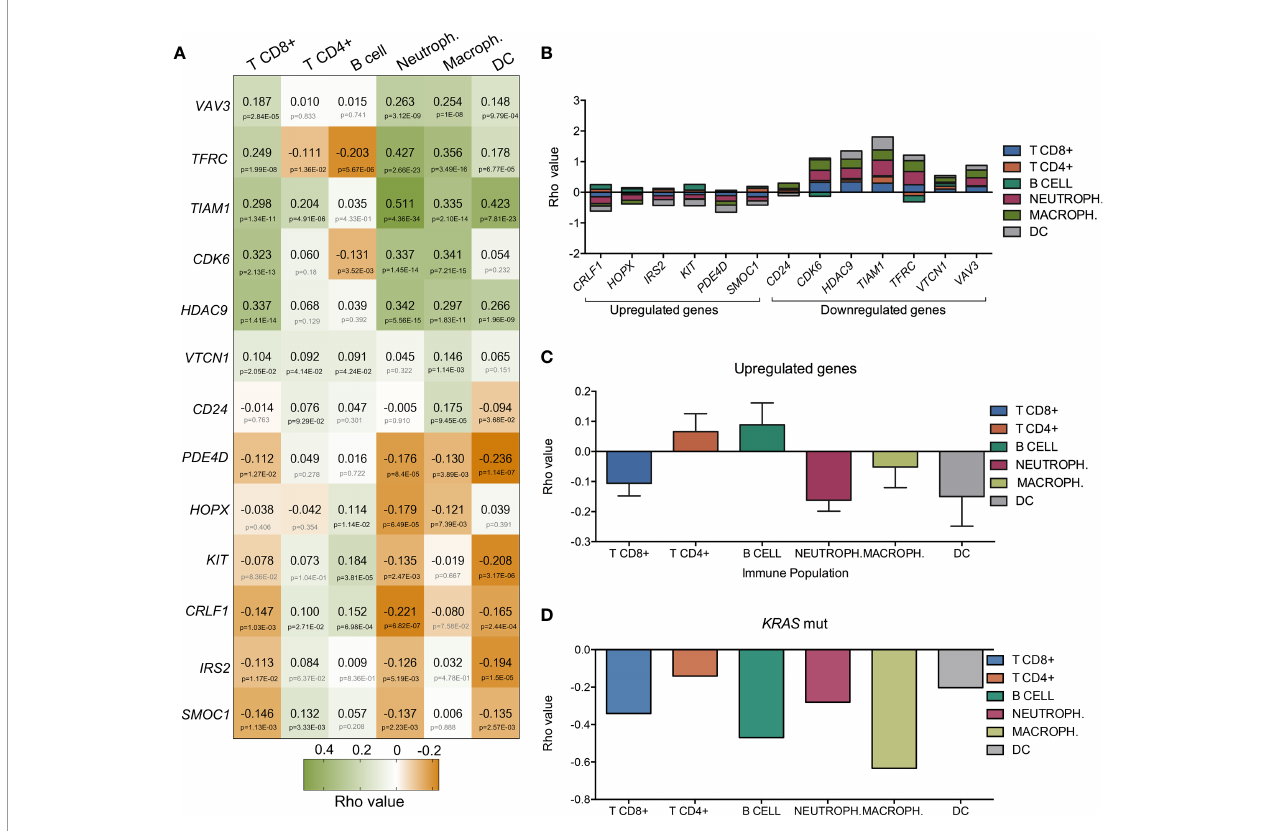
FIGURE 2 | Association of the expression of the thirteen selected genes with immune in fi ltrates in LUAD. (A) Heatmap that represents the correlation (green for positive Rho value and orange for negative one) between gene-expression and the level of tumor immune in fi ltrates (CD8+ T cells, CD4+ T cells, B-cells, macrophages, neutrophils and dendritic cells). Bellow Rho value, p-value is shown (in grey if no signi fi cant and in black if signi fi cant). (B) Bar graph showing the accumulative correlation to all immune populations named above with the expression of up and downregulated genes . (C) Rho values indicating the correlation between expression of upregulated genes ( CRLF1, HOPX, IRS2, KIT, PDE4D , and SMOC1 ) and immune populations. (D) Correlation between K-RAS mutated gene and immune in fi